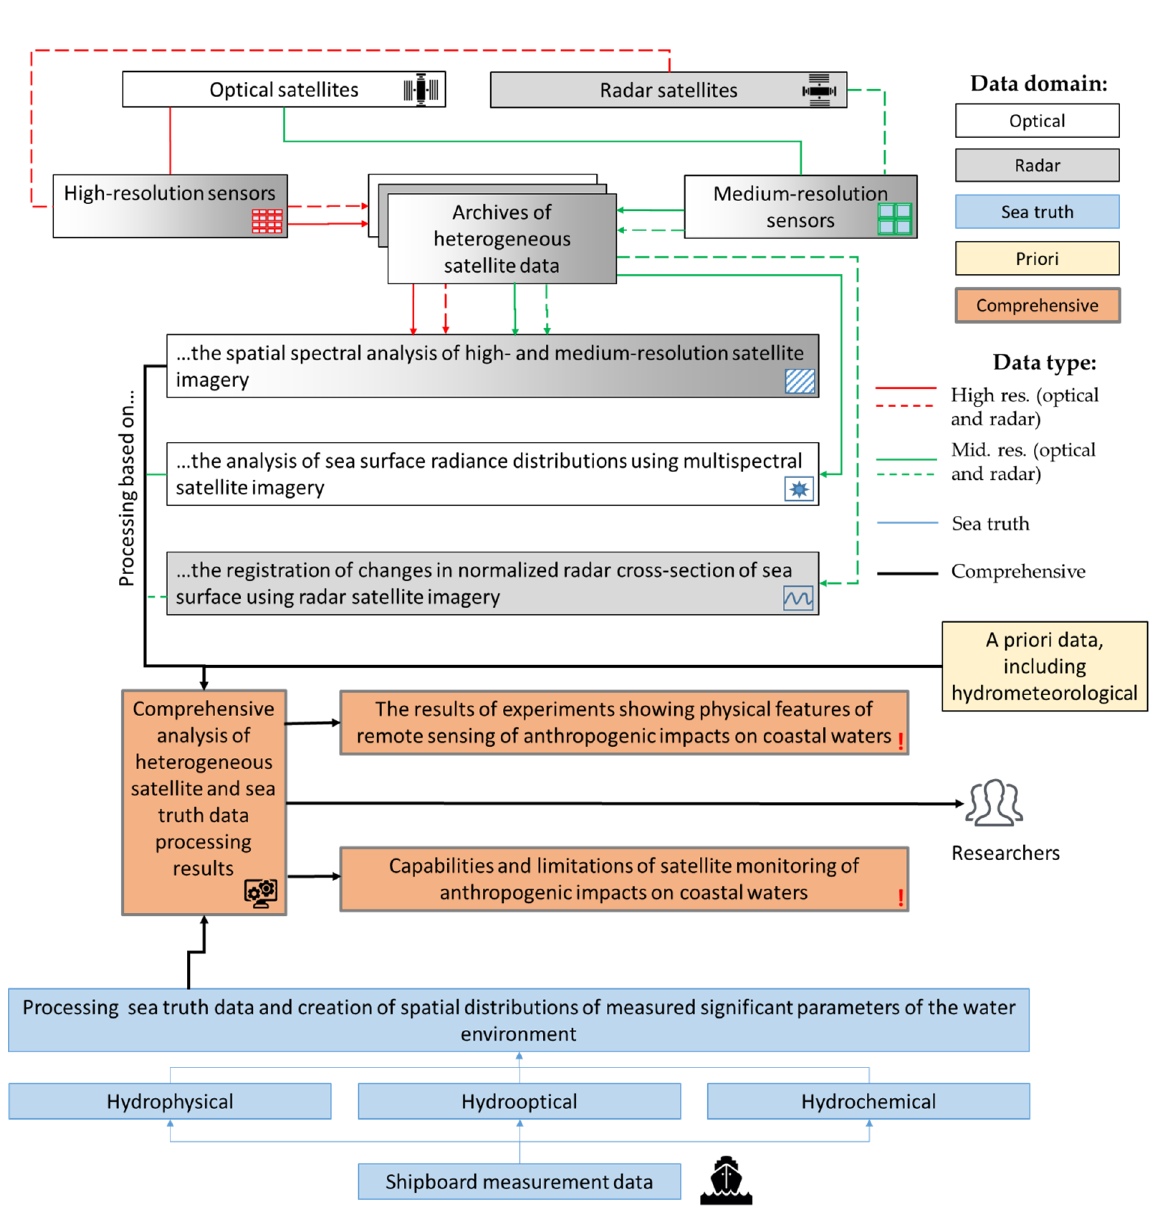
Figure 1. General flowchart of the research methodology.